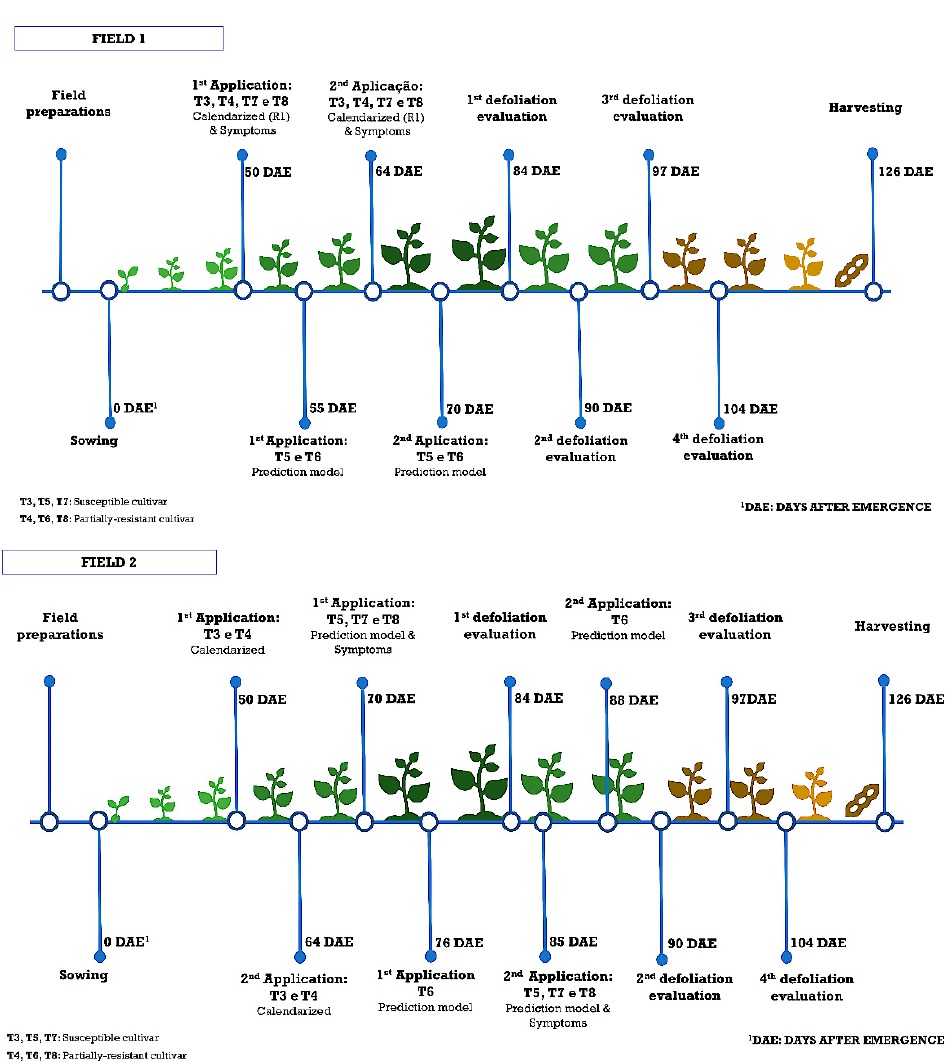
Figure 2. Graphical representation of fungicide application timings along with qualitative and quan- titative spraying evaluations as a function of disease detection that was proposed for each